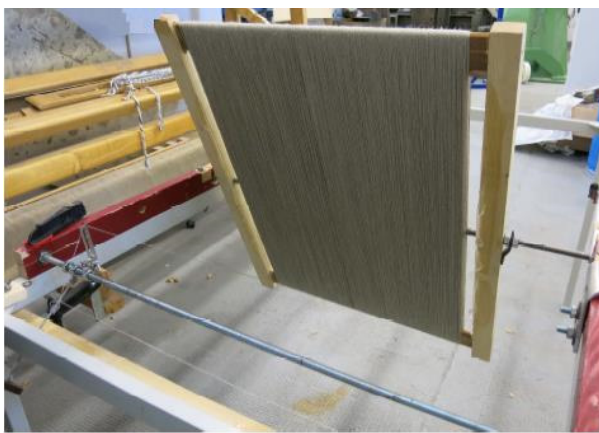
Figure 1: Semi-finished product consisting of flax.